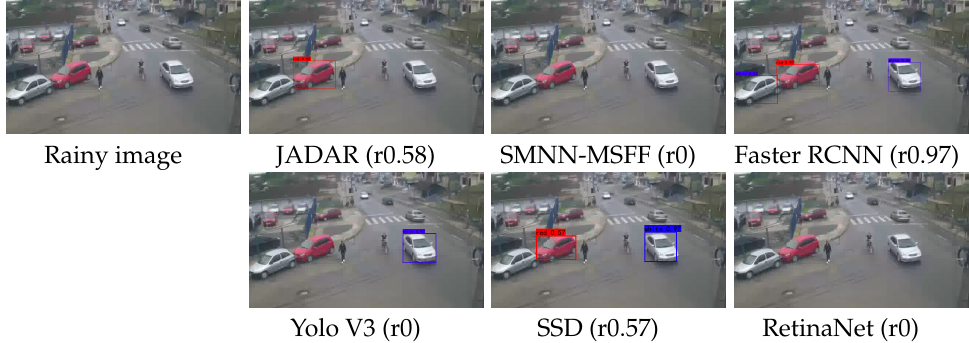
Figure 12. Test results of JADAR and color recognition and object detection methods on the RIS.